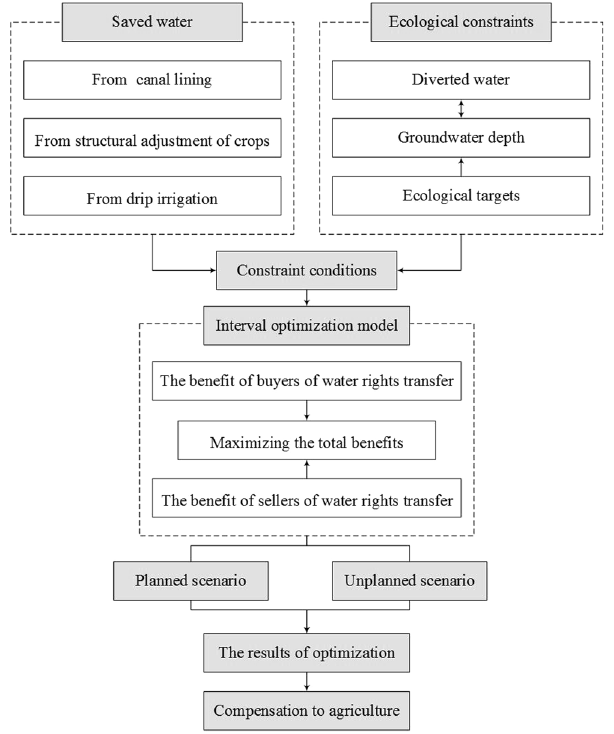
Figure 4. Framework of